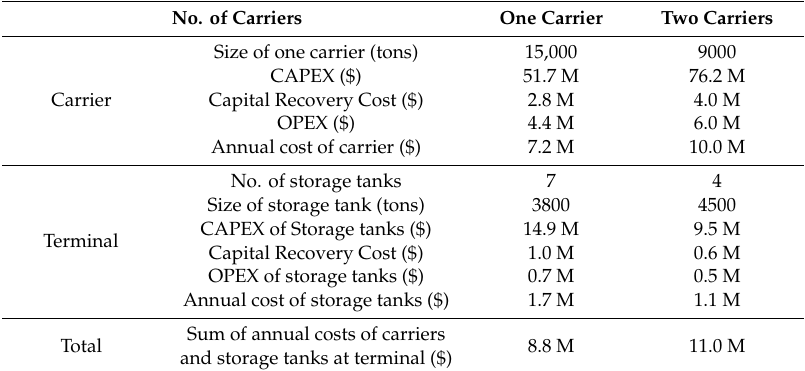
Table 2. Summary of capacity, capital expenditure (CAPEX), and operating expenditure (OPEX) of carrier and CO 2 terminal depending on the numbers of